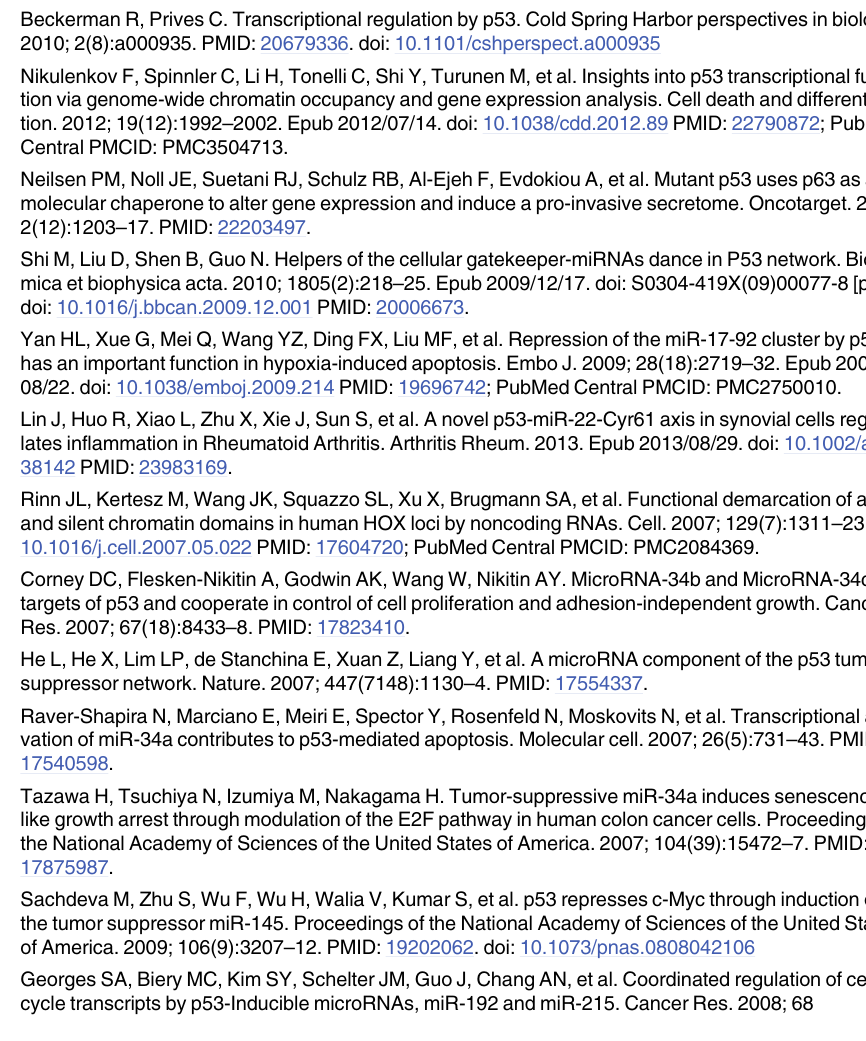
S4 Table. Significant genes in the microarray. All genes significantly regulated in both H1299 and WE-68 cell lines upon p53 activation are listed with fold change and p values. “ Fold change ” refers to the ratio of expression in induced (H1299 treated with PonA and WE-68 treated with Nutlin) versus uninduced cells. Statistical criteria for microarray: fold change > 1.085 or < 0.915, p <